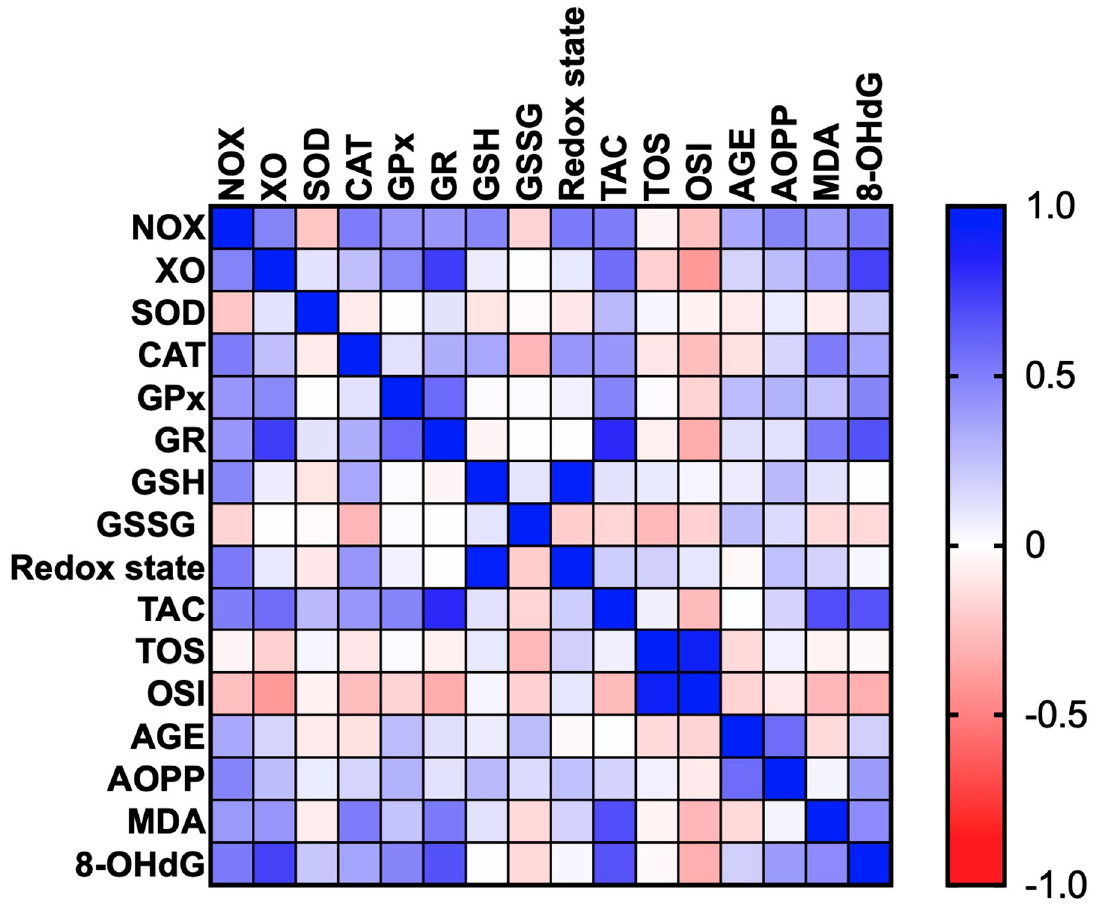
Figure 10. Heat map of oxidative stress parameters in the tumour tissue ( n = 29).